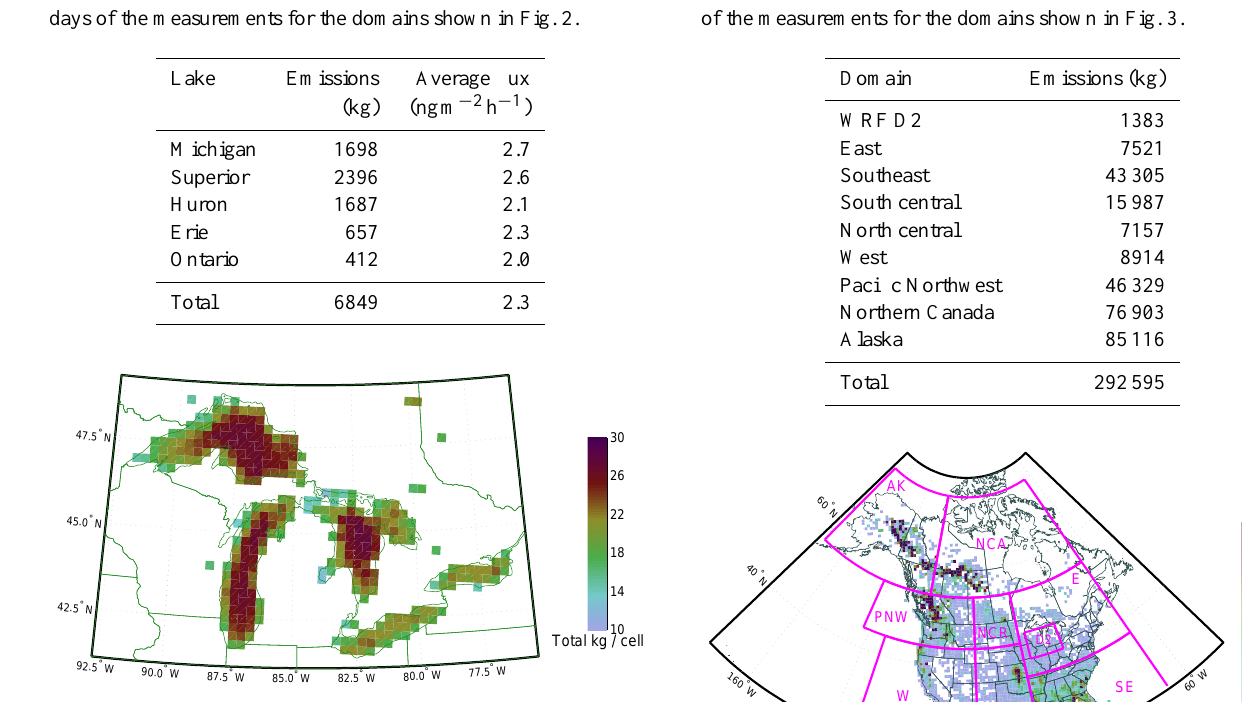
Fig. 2. Gaseous elemental mercury emissions from the lake surfaces summed from 28 June 2004 to 11 May 2005 for WRF domain 1. See Table 1 for total emissions from each lake. Areas with zero emissions shown in white.